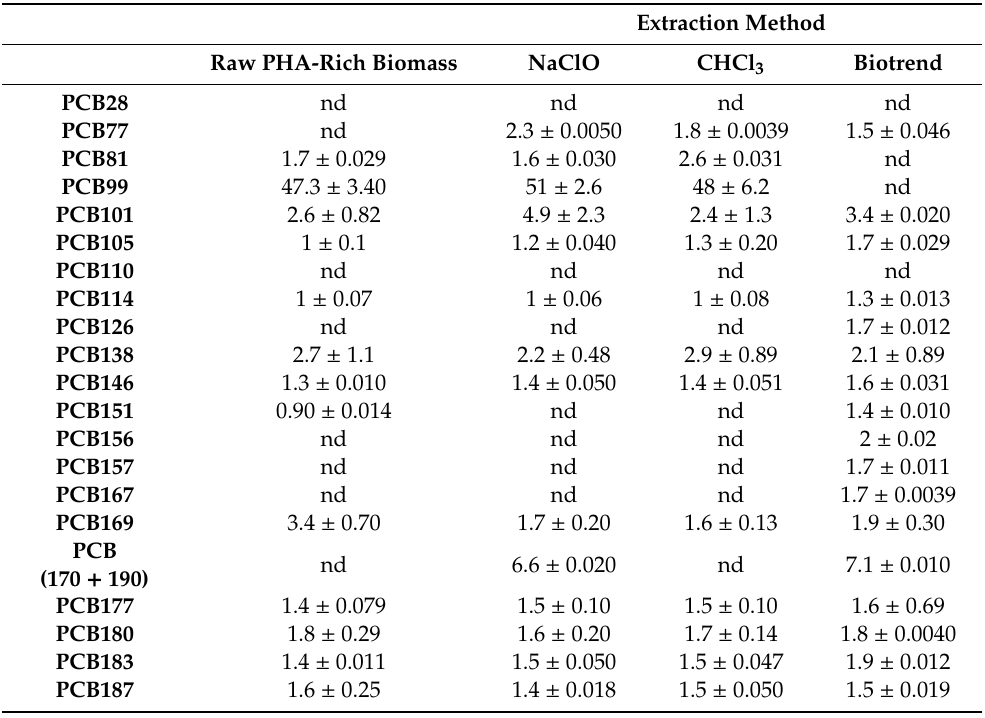
Table 3. Concentrations ( µ g / kg) of PCBs in PHA samples from municipal organic waste / sludge.